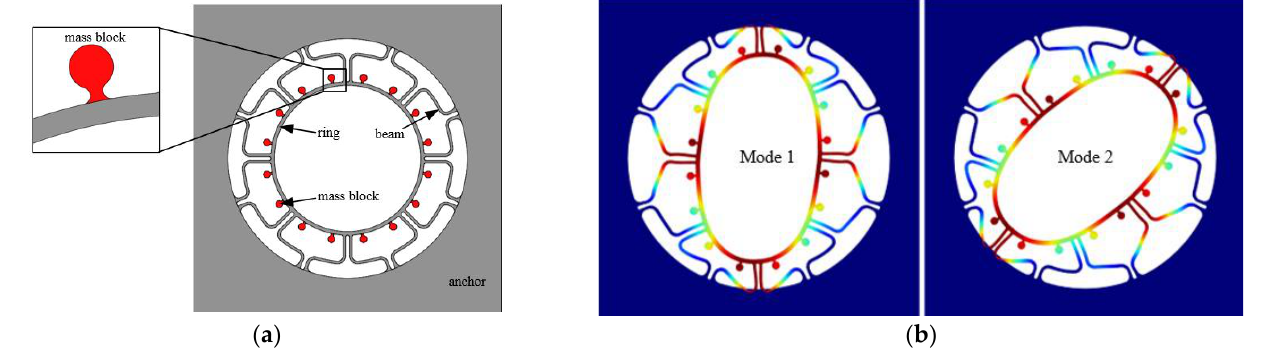
Figure 1. ( a ) New ring resonant structure; ( b ) Simulation of ideal ring resonator.